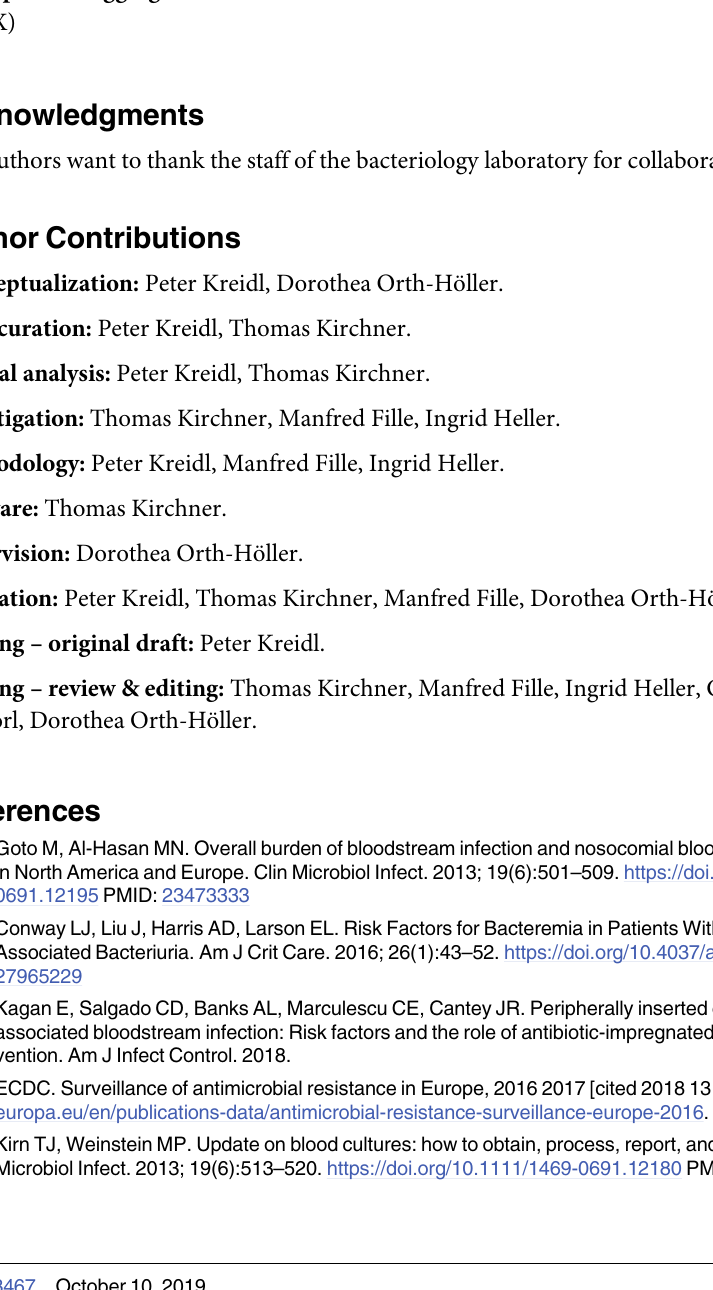
S1 Table. Microorganisms, cumulative incidence/1,000 admitted patients and risk ratio (95% confidence interval) by hospital setting. S2 Table. Number, most commonly isolated pathogens, cumulative incidence/ 1,000 admitted patients by hospital setting. S3 Table. Proportion of resistant strains, cumulative incidence risk ratio (RR) (95% confi- dence